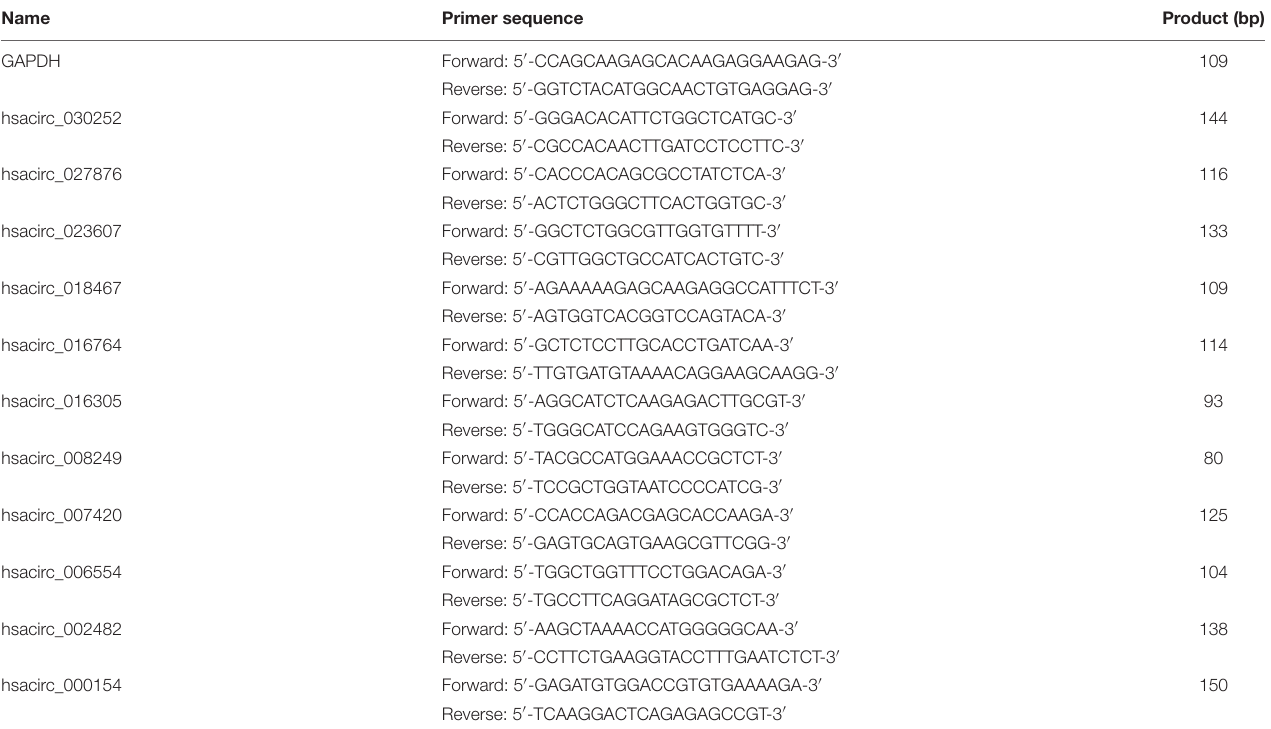
TABLE 1 | Sequences of the primers in the analysis of circRNA expression by qRT-PCR. Name Primer sequence Product (bp)